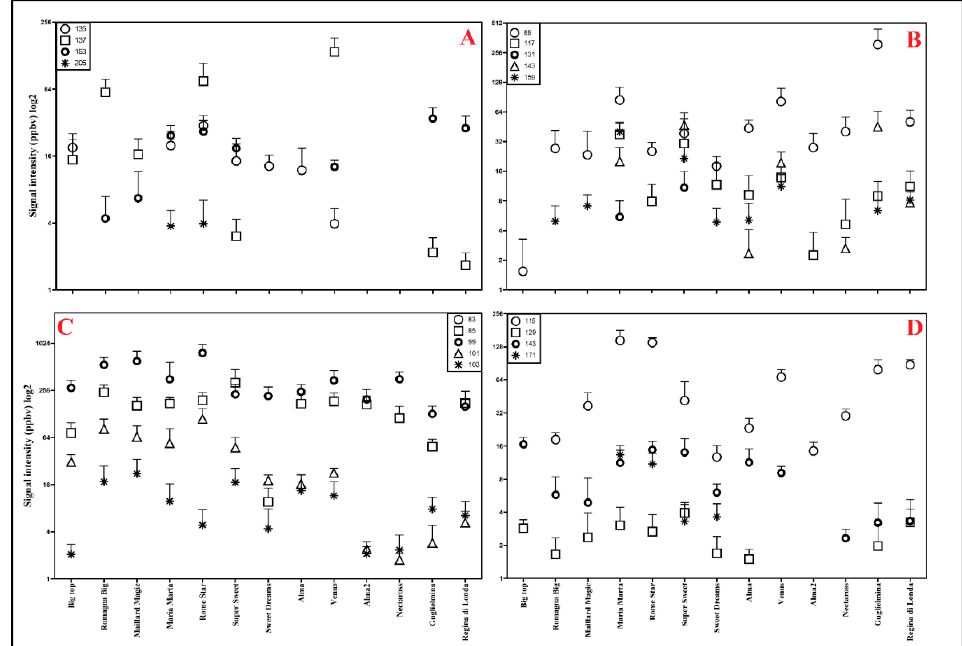
Figure 2. Signal intensities of different VOC types that possess strong peach-like aromas or are identified as impact volatiles in different varieties of peach such us: ( A ) Terpene compounds ( m / z 135.117, 137.132, 153.127, 205.195); ( B ) Ester compounds ( m / z 89.059, 117.091, 131.106, 143.107, 159.140), ( C ) C6 compounds ( m / z 83.086, 85.101, 99.080, 101.096, 103.075), ( D ) Lactone compounds ( m / z 115.075, 129.091, 143.107, 171.137) [34,35].